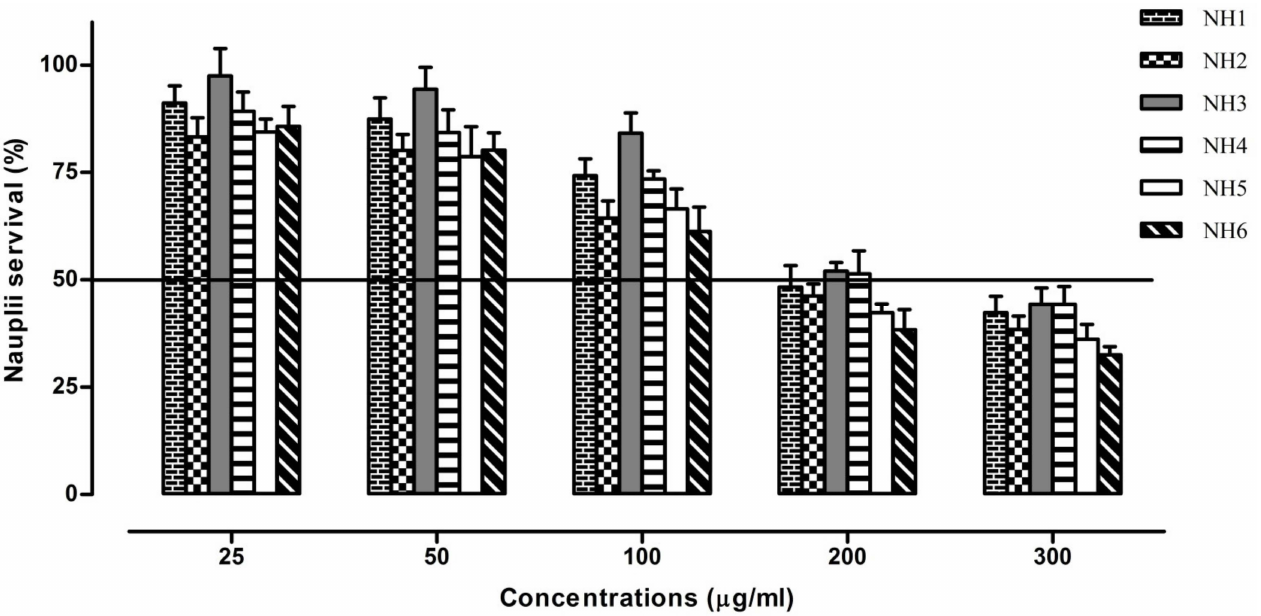
Figure 6. Brine shrimp lethality test for the synthesized hydrazones at various